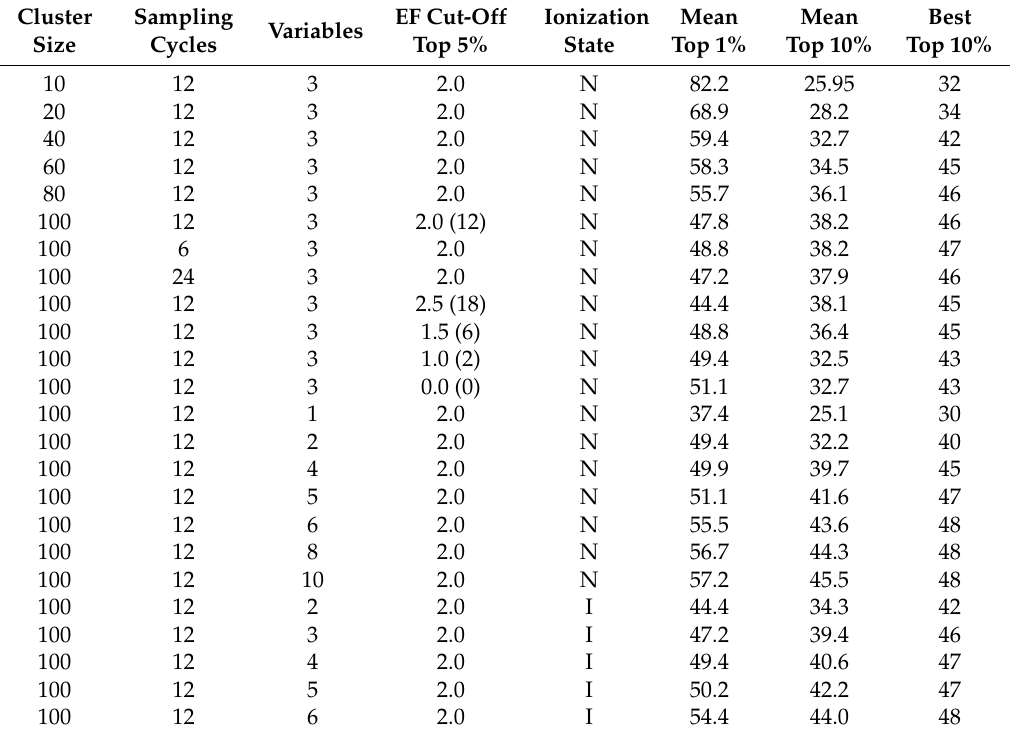
Table 1. Model performances obtained in the calibration